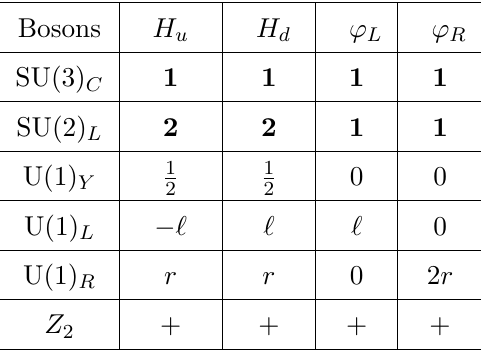
Table 2 . Charge assignments in scalar